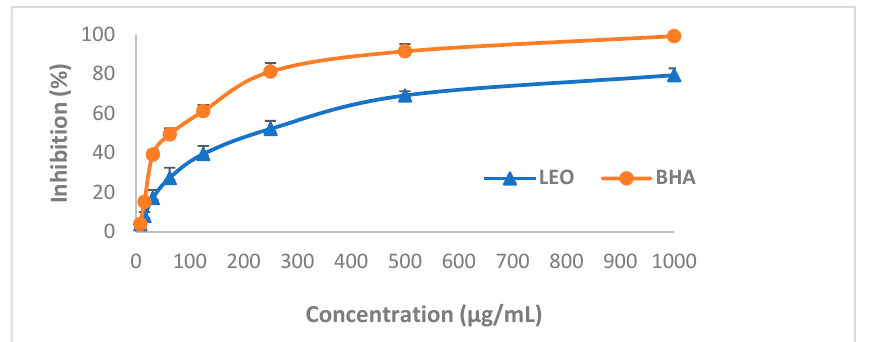
Figure 1. Antioxidant activity of lavender essential oil (LEO) and antioxidant standard 3-tert-butyl-4-hydroxyanisole (BHA).